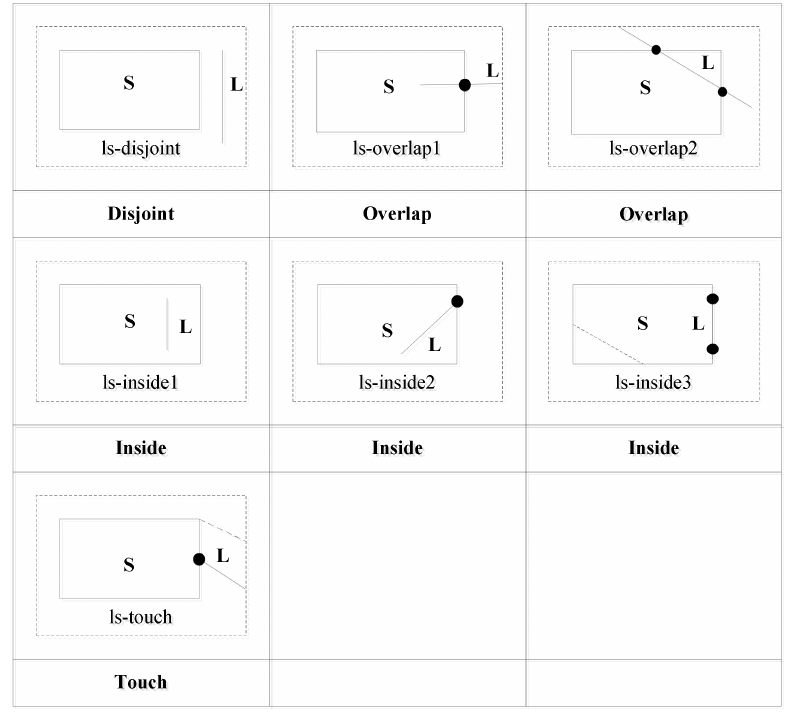
Figure 11. Topological relations between a line segment and a polygon.